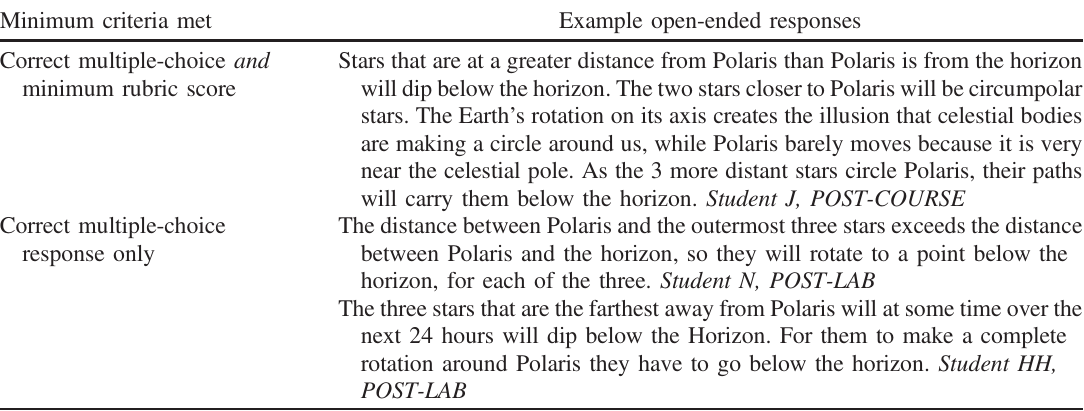
TABLE III. Example open-ended responses given for the assessment regarding the apparent motion of stars near Polaris with respect to the